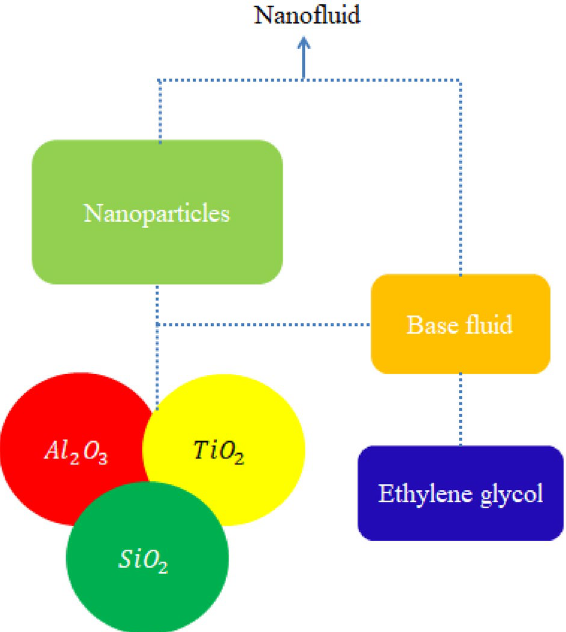
Figure 1. Prepared scheme of tri-hybrid